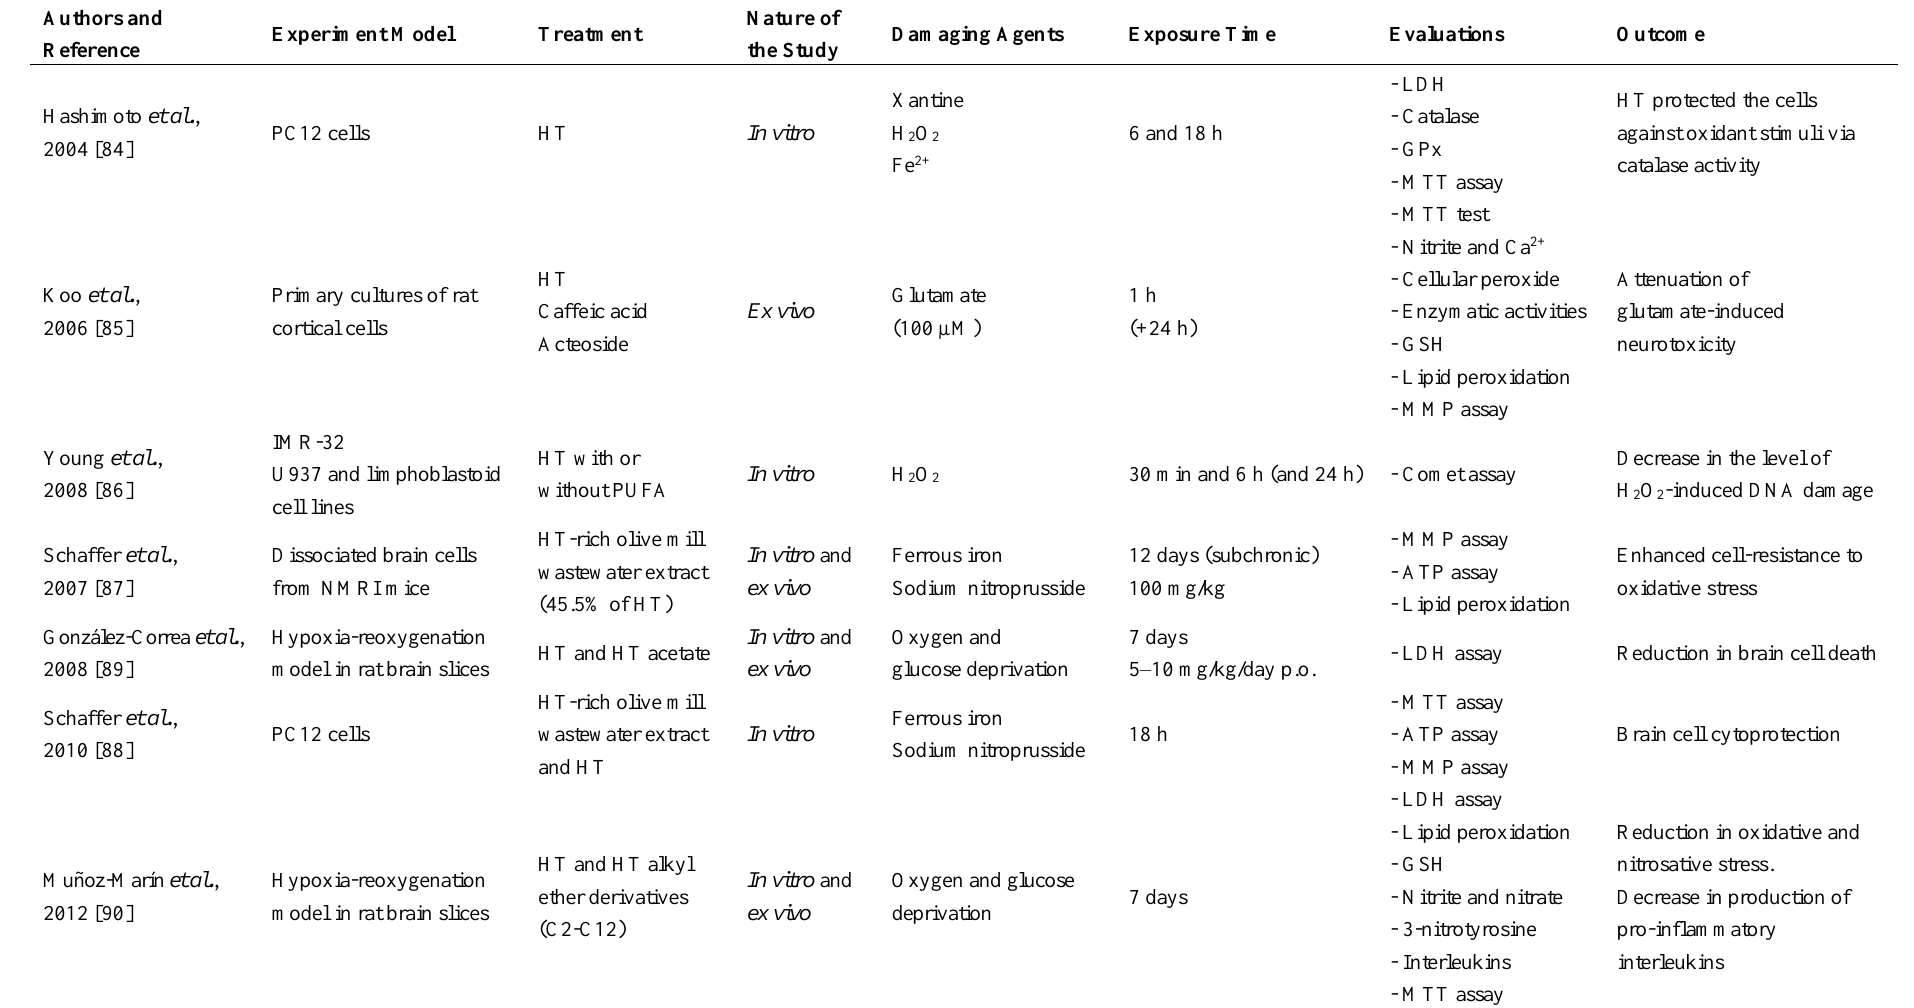
Table 1. In vitro and ex vivo studies related to hydroxytyrosol (HT) neuroprotective effects via direct antioxidant